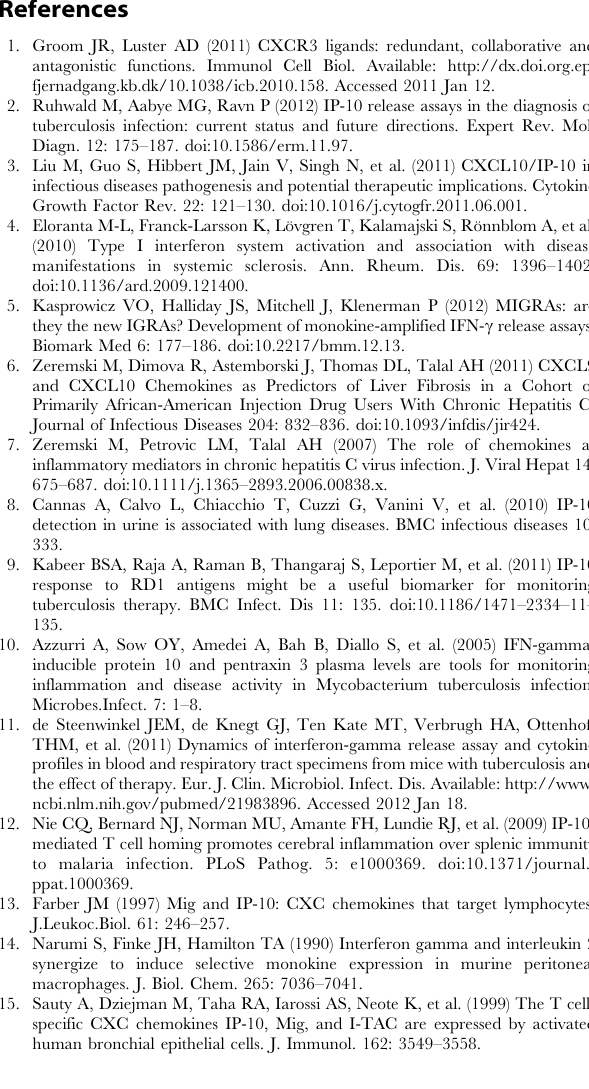
Table S7 Stability of IP-10 in dried plasma spots. Stability studies determine the longest time IP-10 in a DPS sample can be stored before it deteriorates and produce inaccurate results. Stability was determined by leaving DPS samples at 5 u C, 23 u C, 37 u C and 50 u C for 0–4 weeks as listed in the table 7 A–D. Recovery was within our acceptance range of 70–130%, indicating that DPS samples can be safely stored at + 5 u C–37 u C for at least 4 weeks without significant loss in recovery, and at 50 u C for up to 2 weeks. Similar results were obtained for whole blood samples (data not shown). Table S8 Stability of IP-10 in plasma stored at + 5 6 C for up to 6 weeks. The stability of IP-10 in plasma was determined by leaving samples at 5 u C for the weeks listed in the table. Samples were within our acceptance range of 70–130%, indicating that samples can be stored at + 5 u C for at least 6 weeks with no loss of signal. Table S9 Stability of IP-10 in plasma with storage at room temperature + 23 6 C. The stability of IP-10 in a plasma sample stored at room temperature was assessed. %Recovery is calculated by comparing the value of the treated sample to the